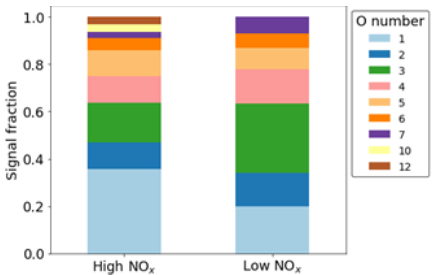
Figure 10. Normalised signal fraction of ring-retaining products un- der high- and low-NO x conditions. Signal for phenol and catechol dominate for both conditions and make up the O 1 and O 2 fractions.